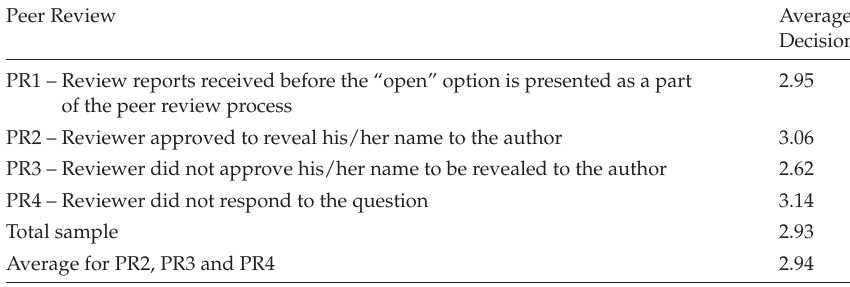
Table 12: Average scores among different groups of review